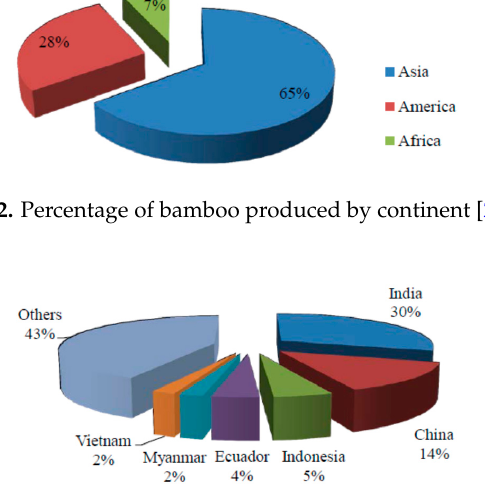
Figure 3. Countries with the largest bamboo resources [21].